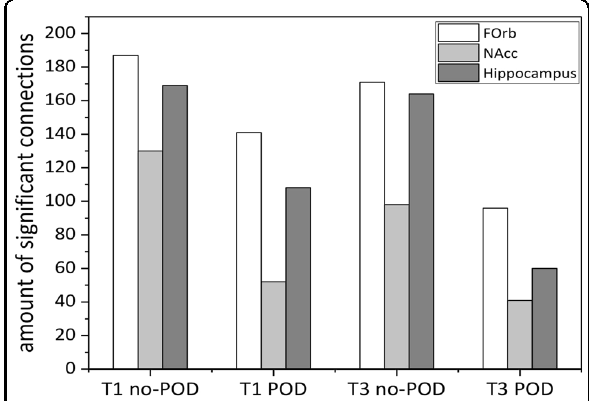
Fig. 2 Amount of signi fi cant connections (FWE corrected, p < 0.05) for each time point and each group including the three seeds (orbitofrontal cortex, nucleus accumbens, hippocampus). FOrb Frontal orbital cortex, NAcc Nucleus